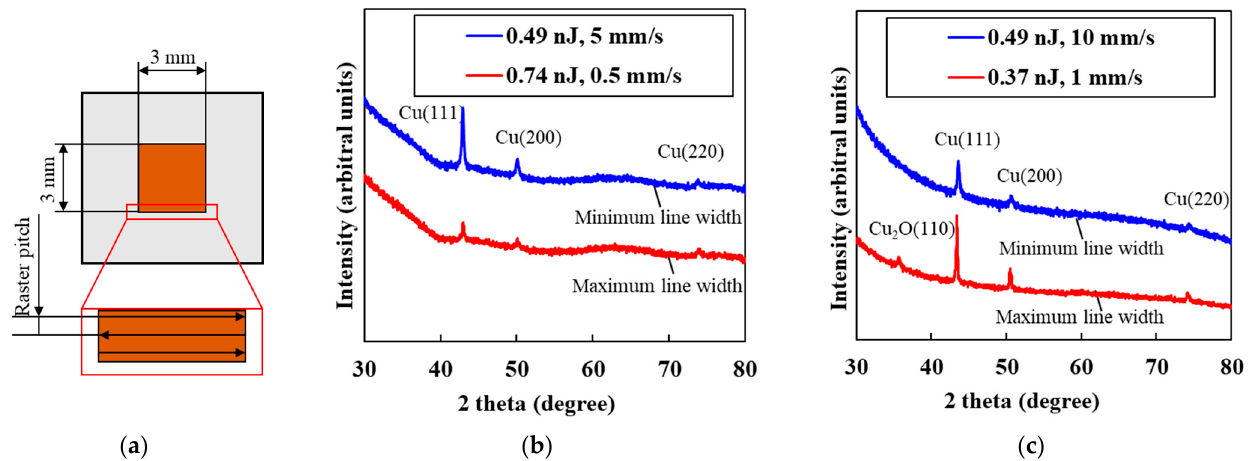
Figure 5. ( a ) Schematic illustration of the patterns fabricated by raster scanning of the focused femtosecond laser pulses. ( b and c ) XRD spectra of the patterns fabricated under the conditions that maximum and minimum line width were formed on glass and PDMS substrates, respectively.